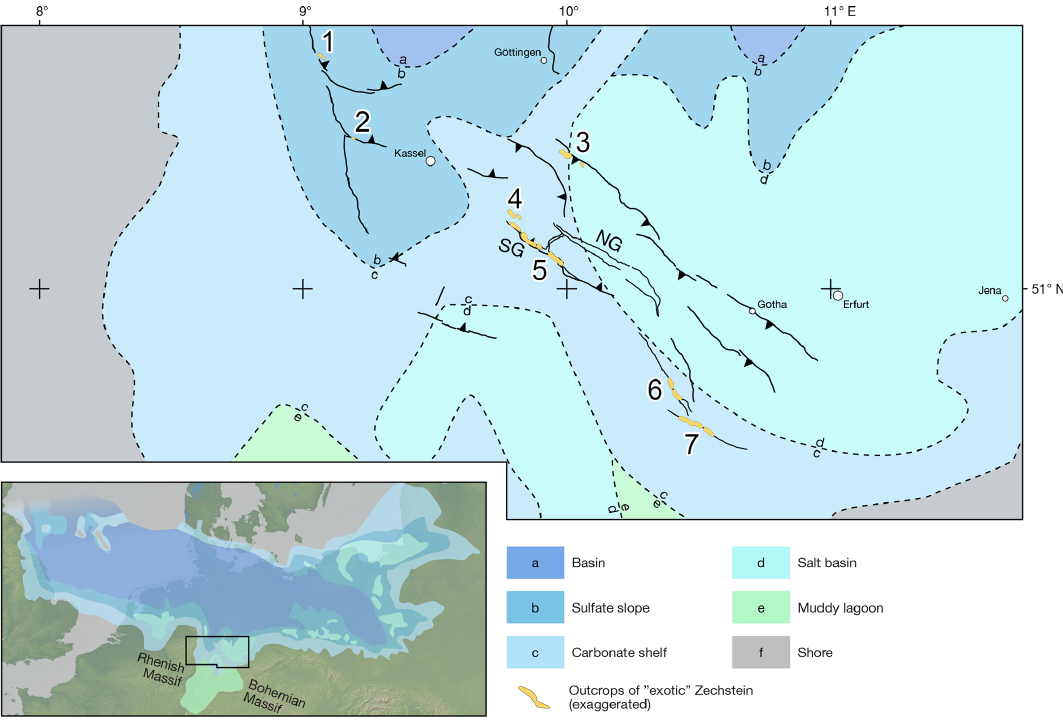
Figure 13. Paleogeographic map of the first Zechstein cycle (Z1, Werra cycle). Outcrops of exotic Zechstein are shown in black for better visibility. Locality 5 is the subject of this study. Zechstein paleogeography from Kiersnowski et al. (1995). Digital elevation model made with GeoMapApp (http://www.geomapapp.org, last access: 11 March 2020); CC